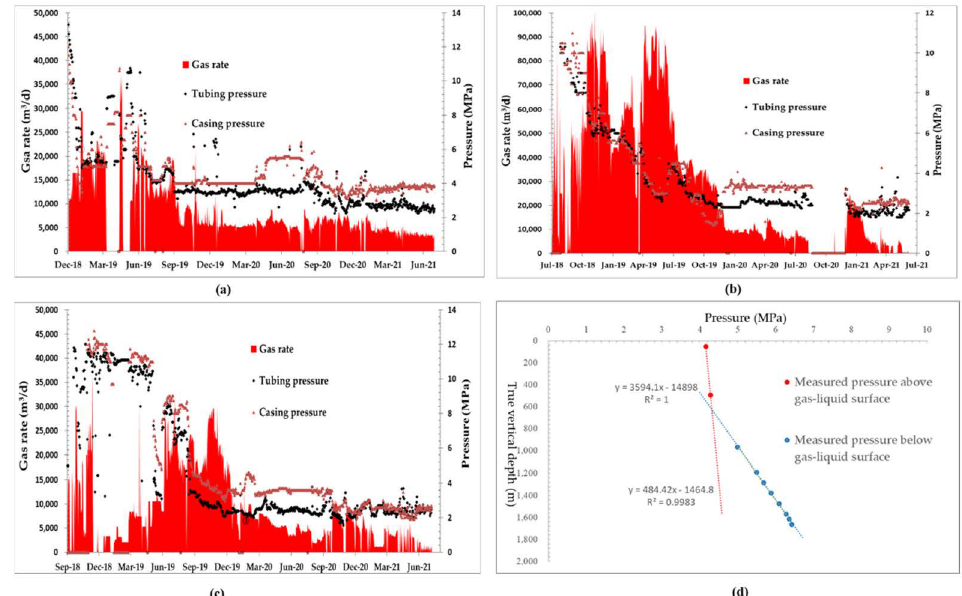
Figure 9. Identification of four types of water-producing gas wells using empirical methods: ( a ) gas rate increasing/decreasing along with tubing pressure increasing/decreasing, ( b ) tubing pressure dropping below casing pressure, ( c ) gas rate dropping sharply after shut-in, and ( d ) fluid density change inside wellbore.